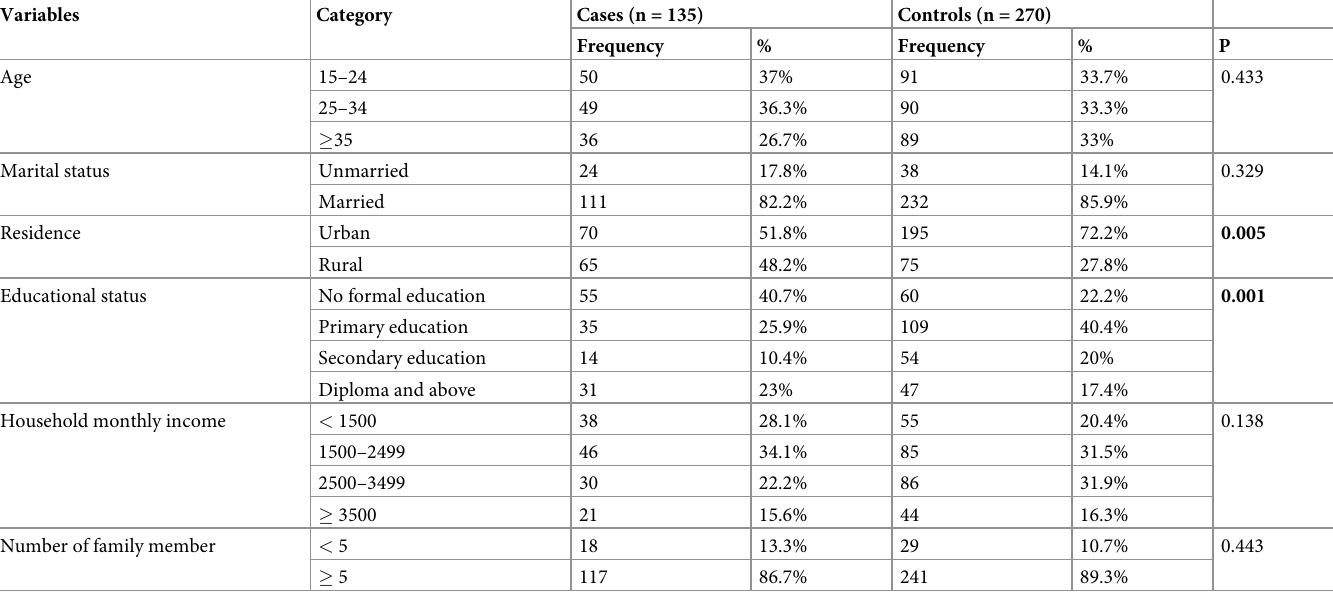
Table 1. Socio-demographic characteristics of mothers who gave birth at public hospitals in Sidama region, Southeast Ethiopia, 2020 (n = 405). Variables